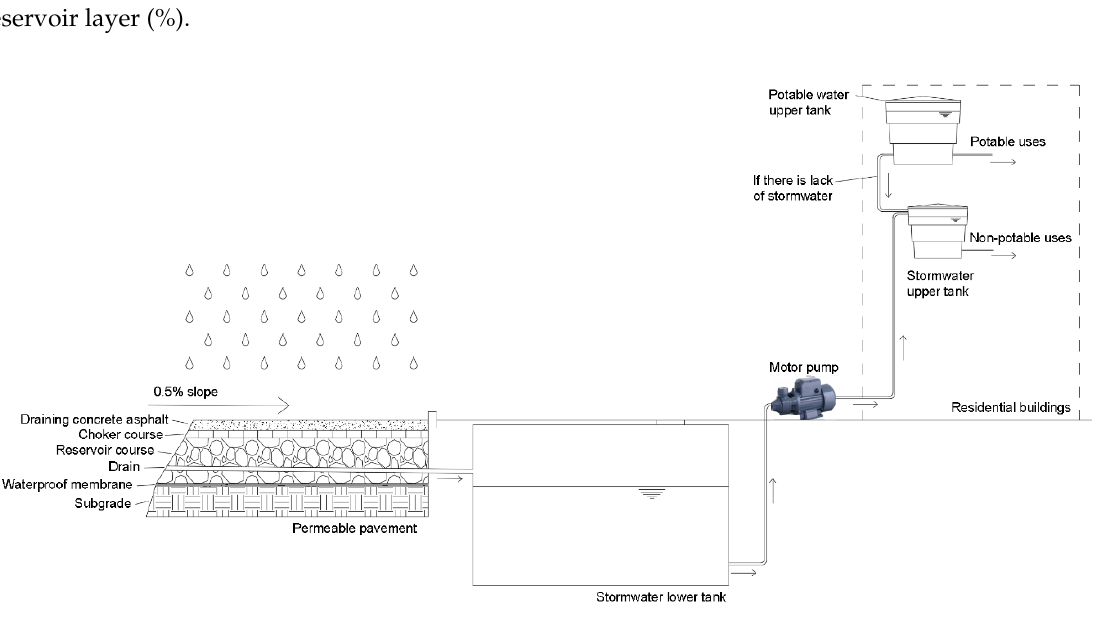
Figure 1. Permeable pavement model and stormwater harvesting system proposed.